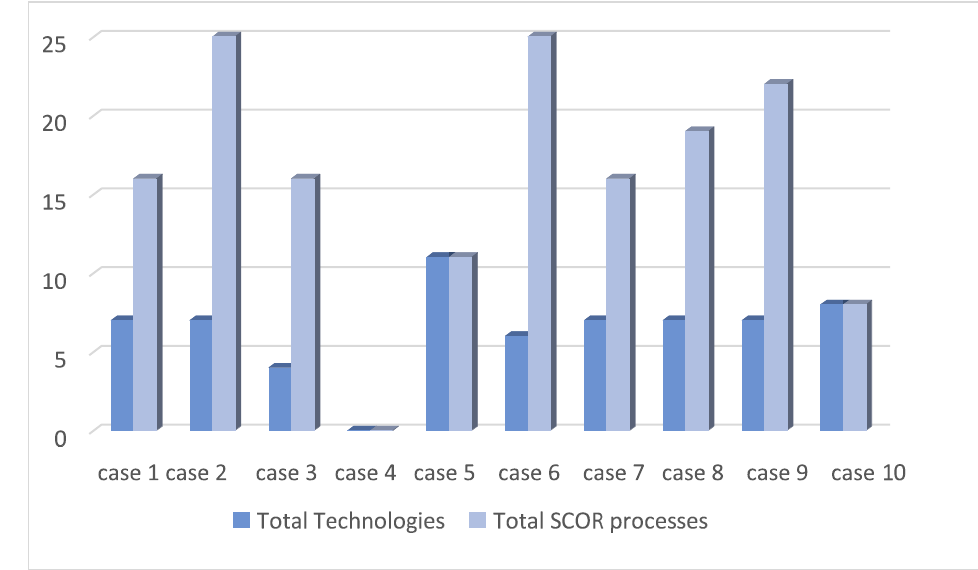
Figure 4. Number of Advanced Technologies and SCOR processes supported by case study.